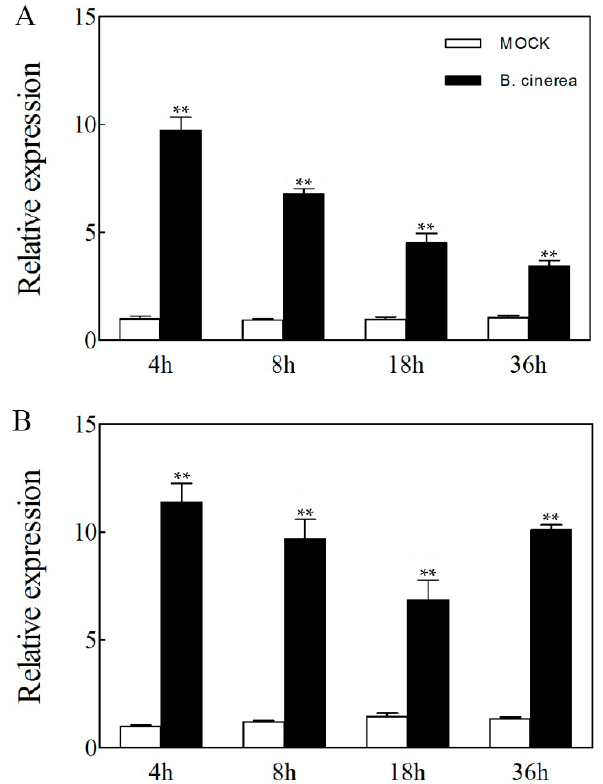
Figure 1. Expression analysis of VaERF20 in Chinese wild Vitis , V. amurensis Rupr “Shuangyou” ( A ) and V. vinifera cv “Red Globe” ( B ) following inoculation with Botrytis cinerea . Data represent the means ± standard deviation from three independent experiments. Asterisks indicate statistical significance (** p < 0.01, one-way ANOVA) between treatment and mock.